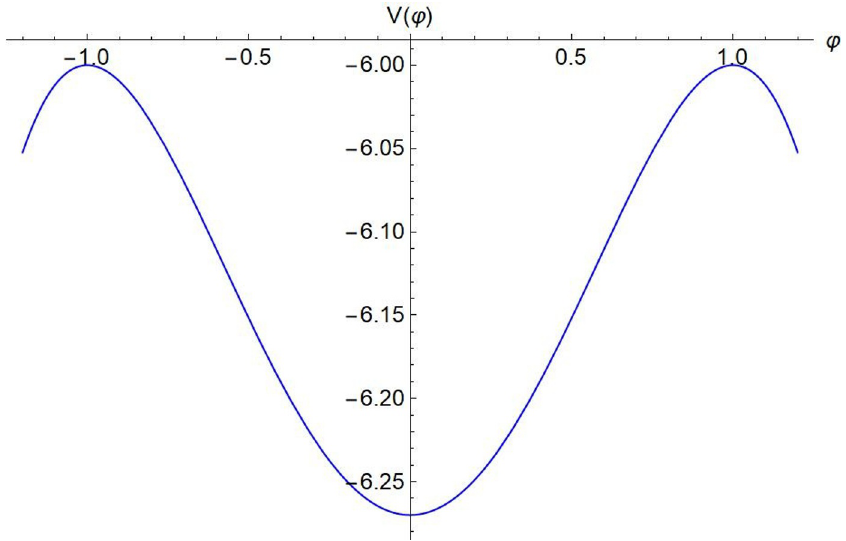
Figure 2 . Plot of the scalar potential with parameters ∆ = 1 . 8 , ‘ = 1